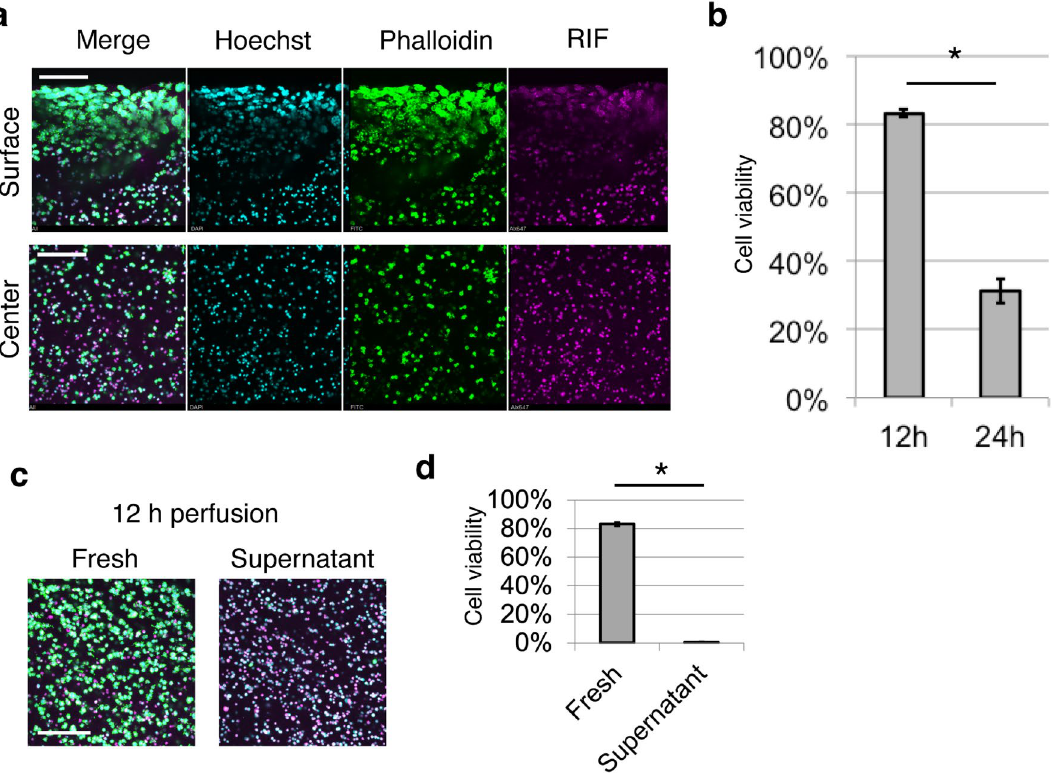
Figure 2. Continuous flow of fresh medium is important for the maintenance of cell viability. ( a ) Fluorescent images after 3 days of culture with PCC-WLD based on the live/dead assay. The medium was replaced every 24 h. Scale bar, 200 μm. ( b ) Analysis of the live/dead assay between 12 and 24 h medium replacement. ( c,d ) Fluorescent images ( c ) and analysis ( d ) of the perfusion culture with fresh or supernatant medium based on live/dead cell assay. The water level difference was restored every 12 h for 3 days. ( a,c ) Cyan, Hoechst. Green, phalloidin. Magenta, RIF. Scale bar, 200 μm. ( b,d ) n = 9 fields from 3 independent experiments. Mean ± S.E. *p < 0.0001 by Welch’s t